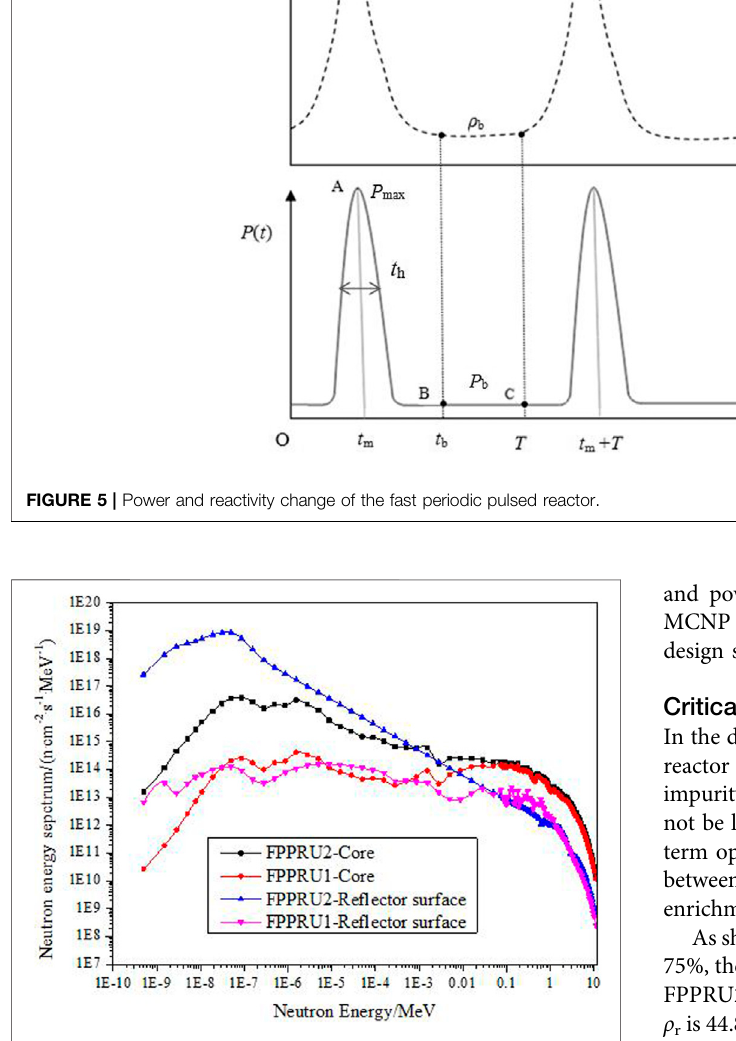
Frontiers in Energy Research |